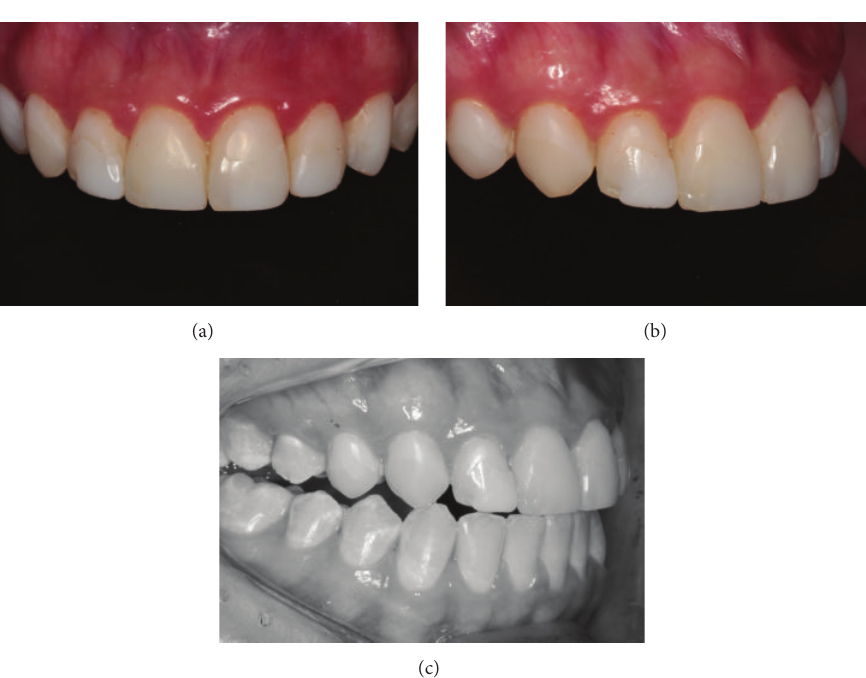
Figure 2: Close-up view of frontal (a) and lateral (b) anterior teeth showing worn and stained composite resins. (c) Image of right disclusion showing contact of canine as well as lateral and central